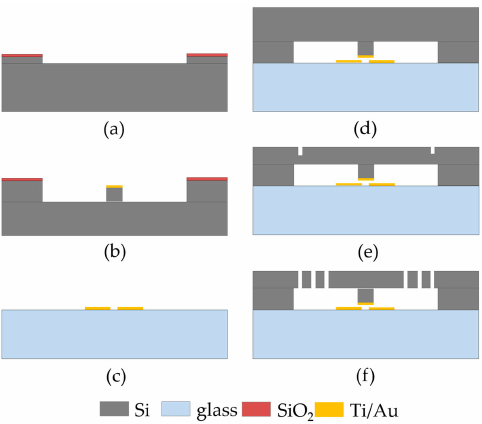
Figure 3. Process sequence for the fabrication of the micro-switch. ( a ) electrode gap; ( b ) protrusive electrode; ( c ) double-contact-configuration fixed electrode; ( d ) anodic bonding; ( e ) thinning and pre-release recess; ( f ) structure